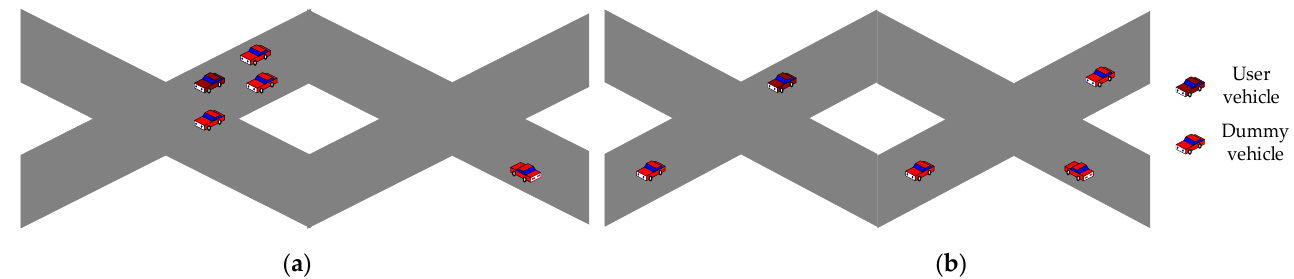
Figure 3. Schematic diagram of vehicle location distribution. ( a ) vehicle aggregation distribution; ( b ) vehicle dispersed distribution.